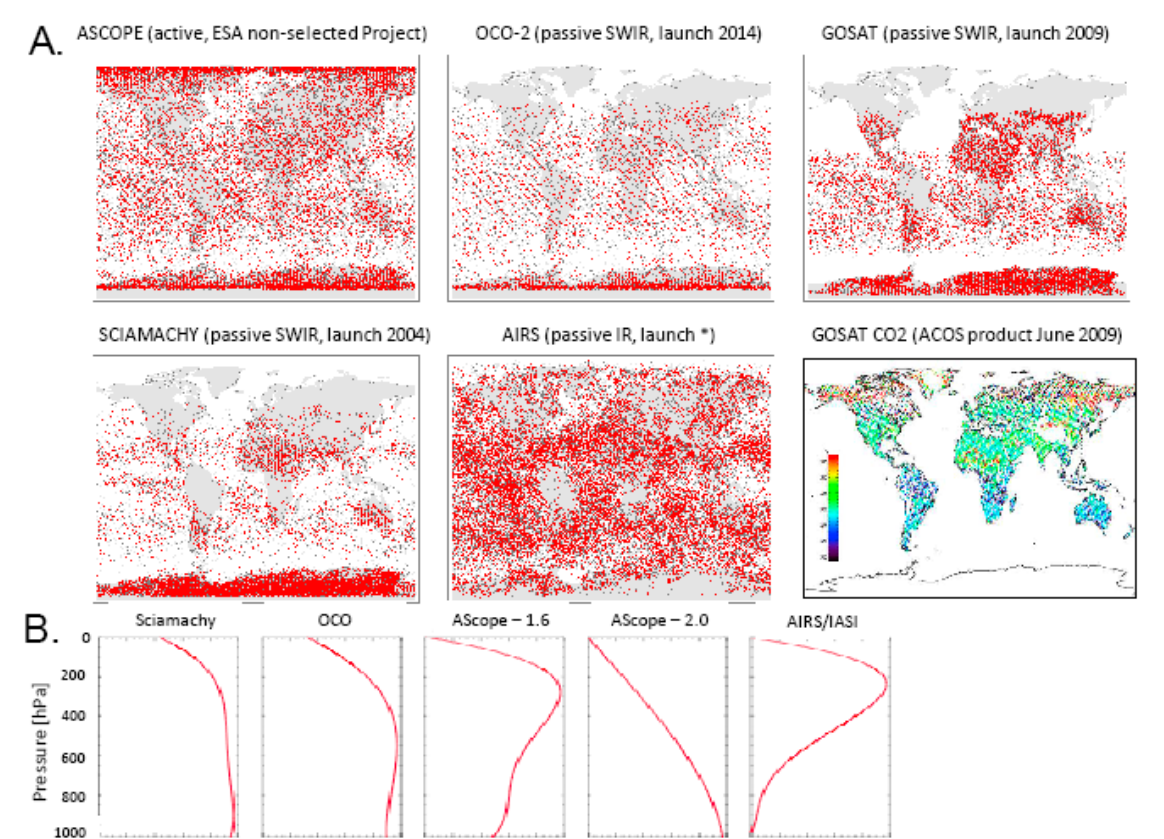
Figure 4. (A) Spatial sampling of the atmosphere by different satellite instruments ASCOPE (an active mission with a lidar not selected by ESA); OCO-2, GOSAT, and SCIAMACHY with measurements of reflected sunlight in near infrared, and their vertical weighting functions; AIRS (or IASI) with measurements from emission in the mid-IR domain, (B) actual column XCO 2 measurements from GOSAT XCO 2 (ACOS product, 2009). X axis units is the dimensionless weight in each atmospheric layer.